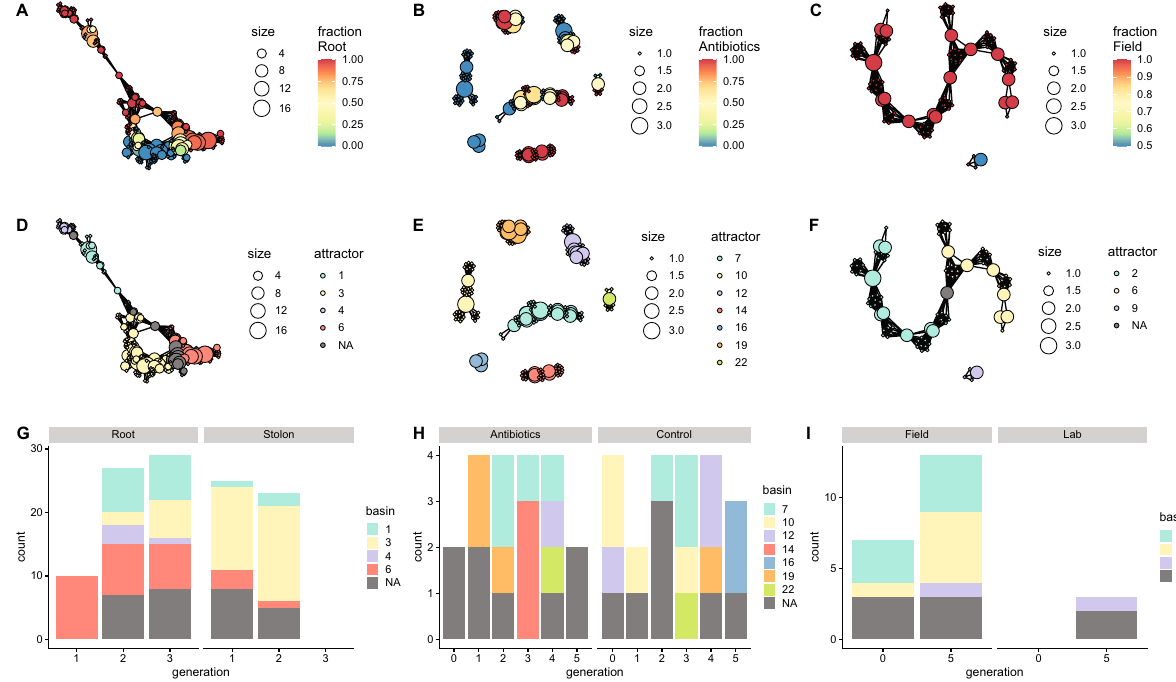
Figure 2. Persistence of the functional composition of plant, zooplankton, and mosquito microbiota across generations. ( A ) Mapper representation of root and stolon plant samples. The colour represents the fraction of root samples per node. ( B ) Mapper representation of the zooplankton samples. The colour represents the fraction of samples from zooplankton communities bred in the lab as opposed to antibiotics in the first generation. ( C ) Mapper representation of the mosquito samples. The colour represents the fraction of samples from mosquito communities bred in field water as opposed to lab water. ( D ) Partition of the plant mapper network into metastable states. Each colour represents a different attractor. ( E ) Partition of the zooplankton mapper network into metastable states. Each colour represents a different attractor. ( F ) Partition of the mosquito mapper network into metastable states. Each colour represents a different attractor. ( G ) Count of plant samples that belong to each attractor, per generation and tissue. R = Root and S = Stolon. ( H ) Count of zooplankton samples that belong to each attractor, per generation and treatment. ( I ) Count of mosquito samples that belong to each attractor, per generation and